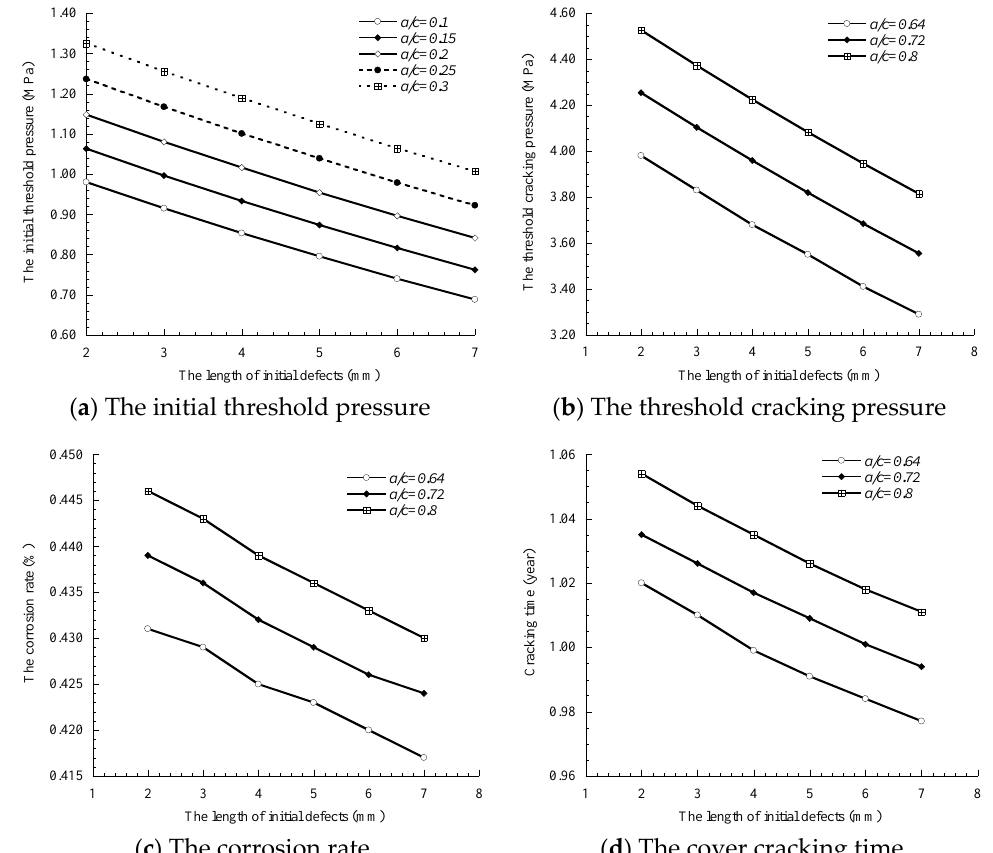
Figure 3. Influence of fine crack on threshold pressure, corrosion rate and cracking time.